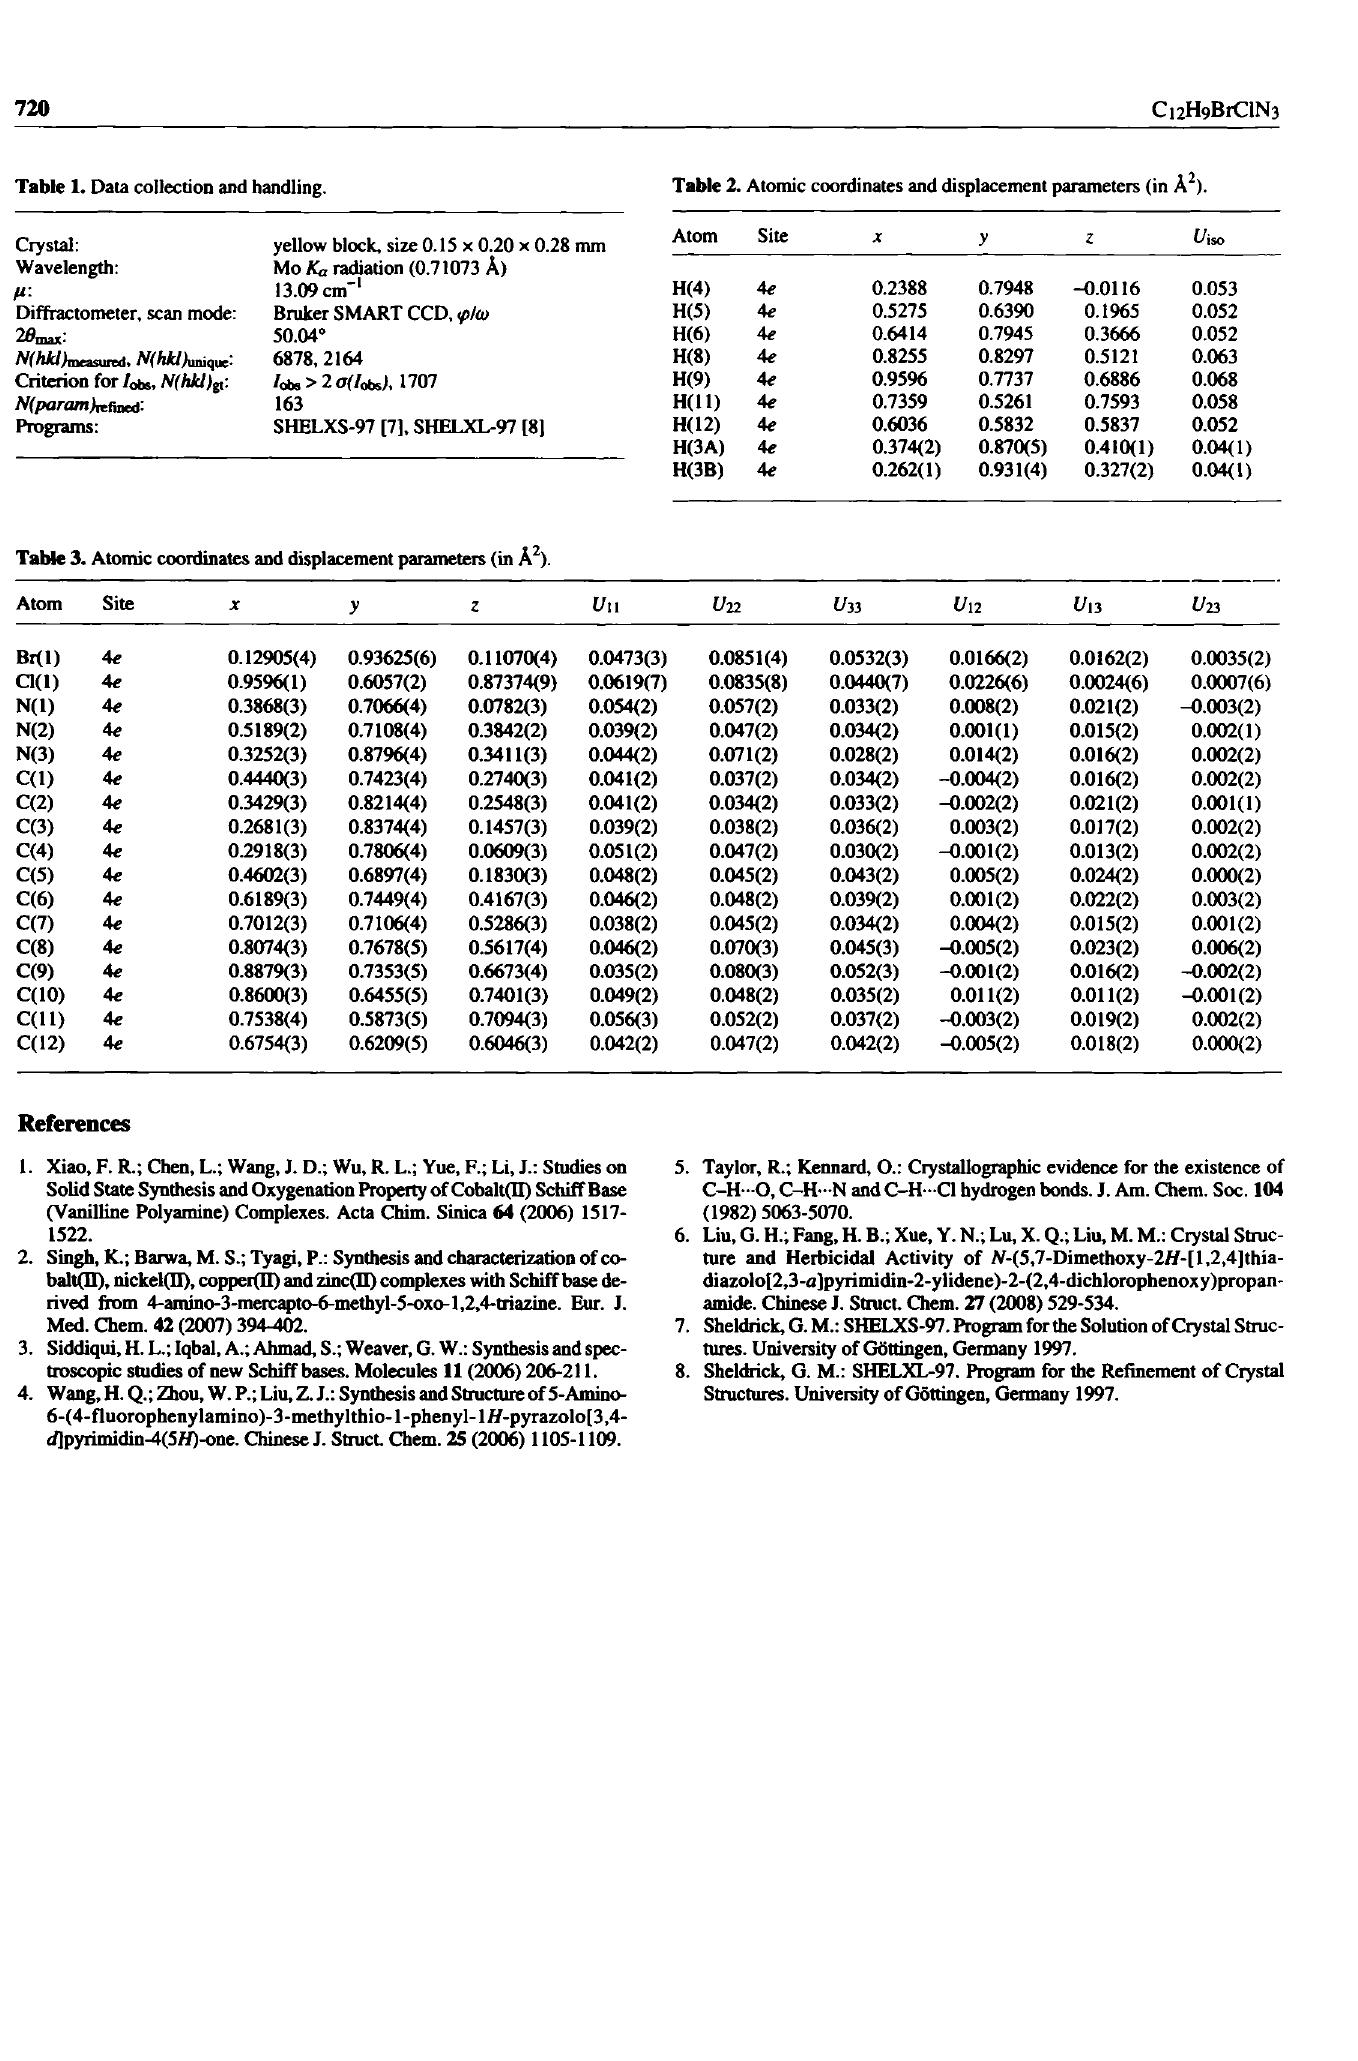
Table 3. Atomic coordinates and displacement parameters (in Â 2